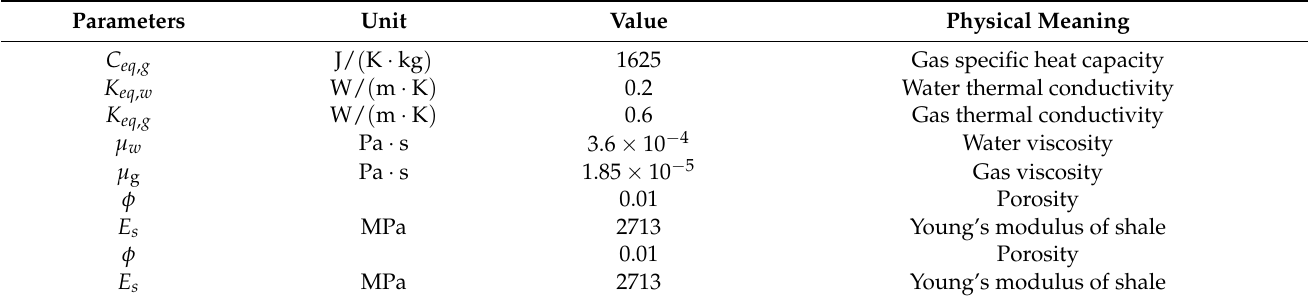
Table 3. The model parameters in the calculations for a gas production